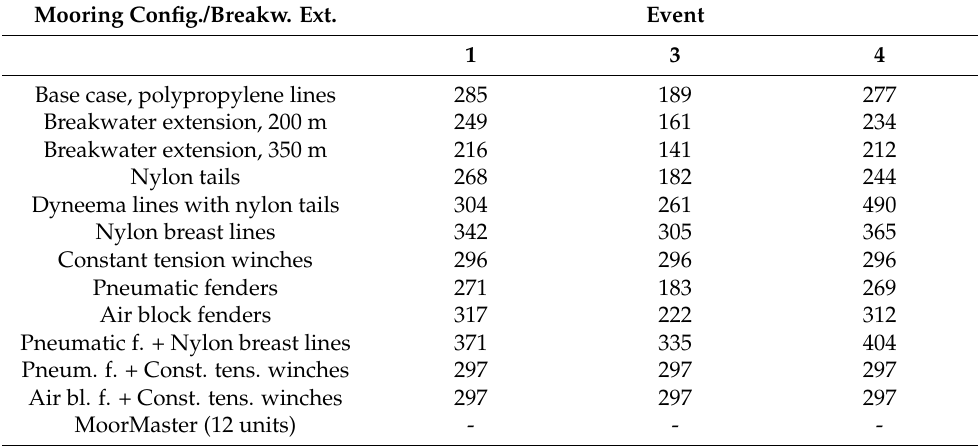
Table 11. Maximum forces in breast lines (kN).